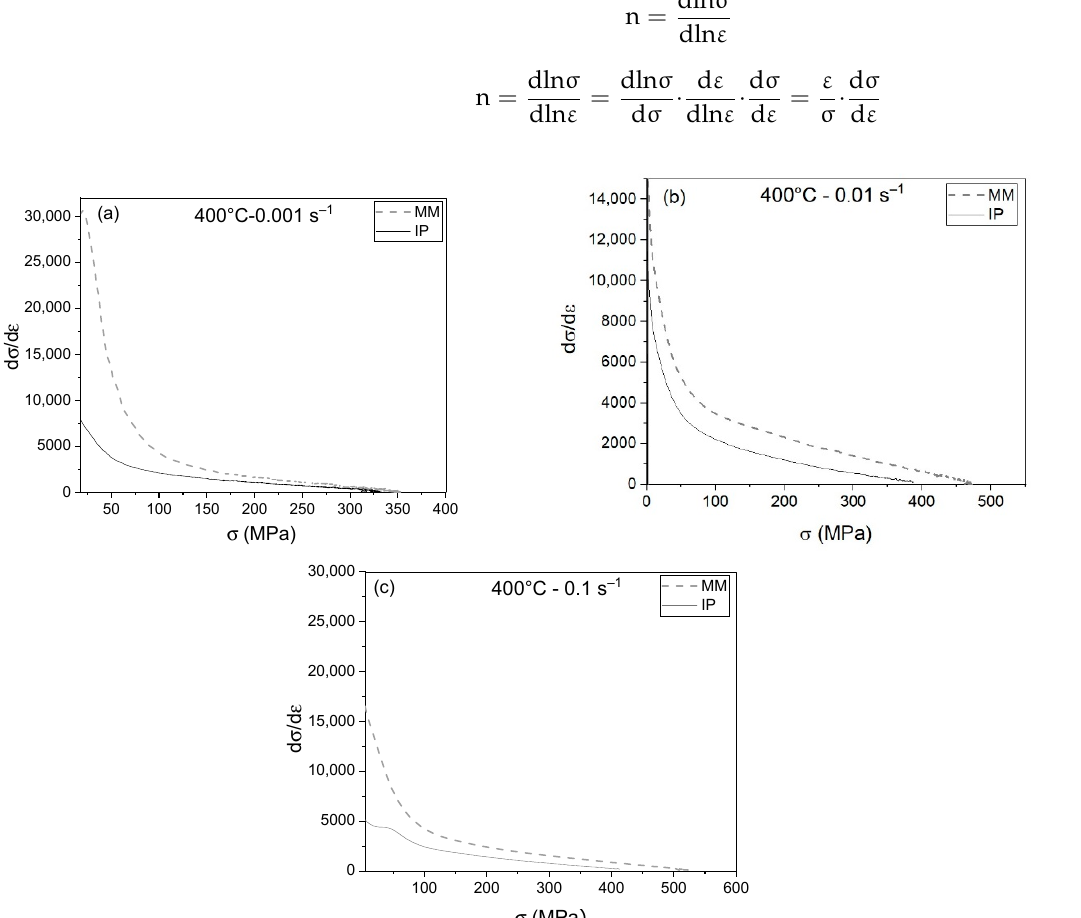
6 of 18 Figure 4. Maximum flow stress σ p of IP and MM at the three different strain rates. ( a ) 0.001 s − 1 ; ( b ) 0.01 s − 1 ; ( c ) 0.1 s − 1 . Strain hardening curves (d σ /d ε = θ ) were derived from the stress–strain curves of Figure 2 and compared for the IP and MM materials. An example of the curves d σ /d ε vs. σ of the IP and MM specimens deformed at 400 °C is shown in Figure 5a–c. It can be seen that the strain hardening values of MM are higher than those of IP. As recently shown by Garcia de la Cruz et al. for pure Ni, a finer grain size should lead to lower strain hardening capability [33], but in HS Ni, the finer grain size of the shell results in a reinforcement effect, able to bear the load of transferring the deformation from the shell to the cores with a consequent higher strain hardening. From the strain hardening curves, the strain hard- ening exponent n, expressed by Formulas (1) and (2), has been calculated. The plots of n are reported in Figure 6 as a function of strain for the IP and MM specimens deformed at the lowest strain rate. At each temperature, the strain hardening exponent n of MM is higher than the corresponding value of IP. The same behavior has also been observed by Ameyama at room temperature [32]. The values of n found by Ameyama in a previous paper regarding harmonic-structured nickel at room temperature were in the range of